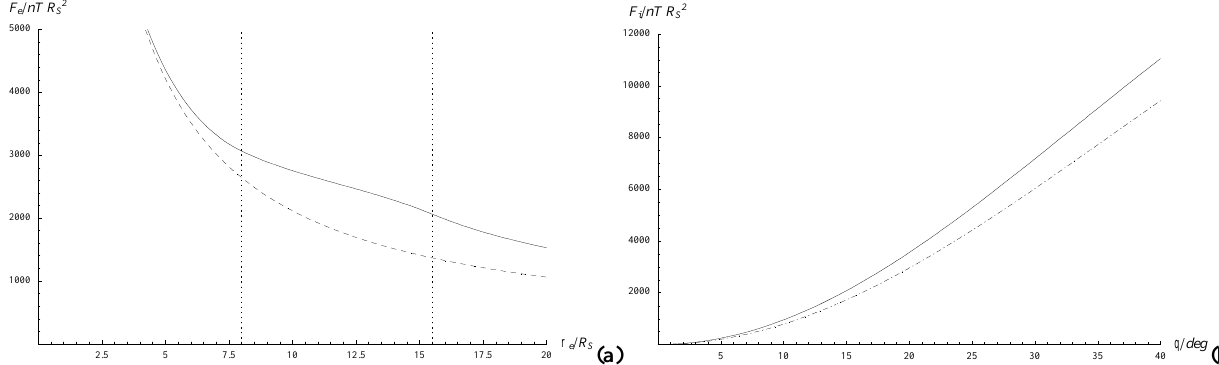
Fig. 2. (a) Plot of the magnetic field flux function in the equatorial plane, F e , versus equatorial distance from the planet ρ e . The units of the flux function are nT R 2 , while the distance is normalised to the conventional Saturn radius R S (60330km). The dashed line corresponds to S the internal field of the planet alone given by Eq. (1) (essentially just the dipole term over the range shown), while the solid line also includes the effect of the Connerney et al. (1983) ring current. The vertical dotted lines show the radial range within which the ring current flows (8–15.5 R S ). (b) Corresponding plot of the flux function in the ionosphere, F i (nT R 2 ), versus co-latitude θ , obtained using the internal S field alone. The solid line shows results for the Northern Hemisphere, while the dot-dashed line shows results for the Southern Hemisphere (plotted versus co-latitude with respect to the southern